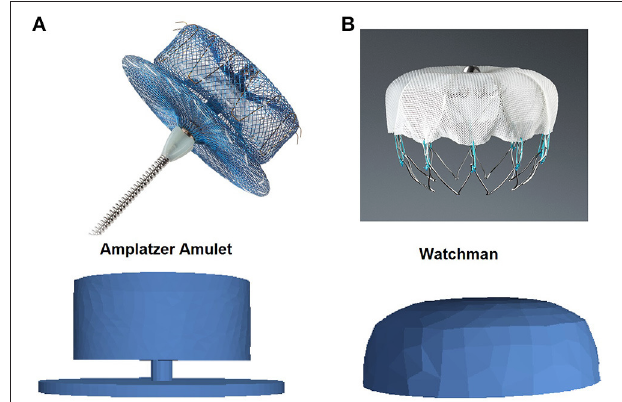
FIGURE 1 | Pictures (top) and Computational-Aided Design models (bottom) of left atrial appendage occlusion devices. (A) Amplatzer Amulet (Abbott, 2018); (B) Watchman (Boston Scientific, 2018).